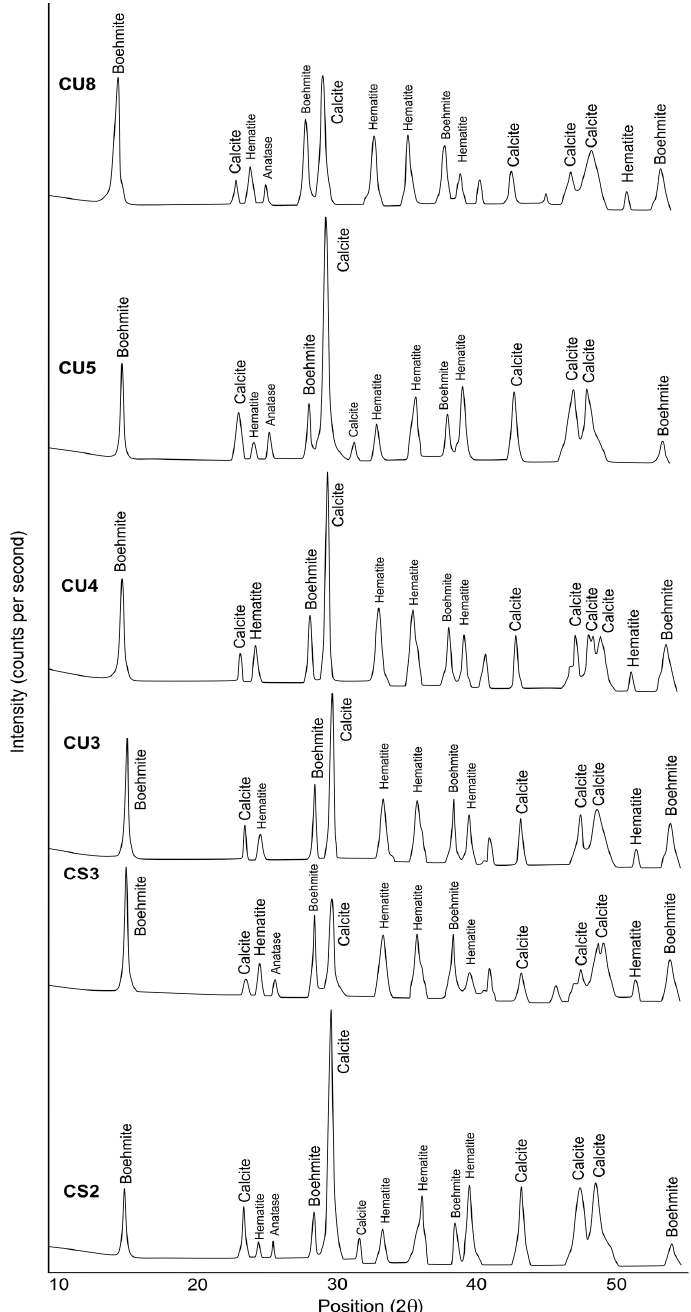
Figure 5. XRPD patterns of selected bauxite